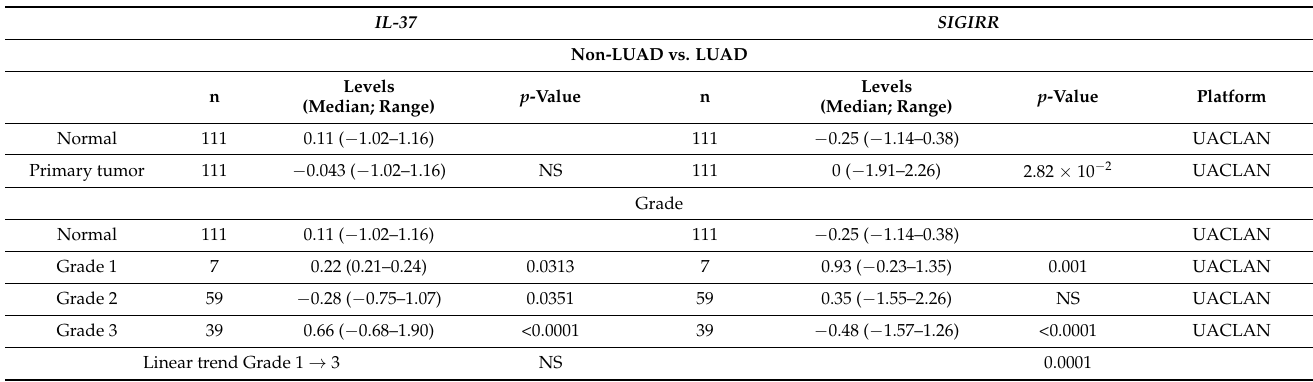
Figure 3. ( A ) Heatmap depicting the relative expression levels (log 2 TPM + 1) of IL-37 and twenty IL- 37-correlated genes in normal and LUAD biopsies as analyzed by RNAseq. ( B ) Dot plot diagrams showing the correlation between IL-37 and each of the twenty significantly positively correlated genes. No negative associations were detected. Pearson’s r values are reported in each case. All p -values were <0.0001. Figures were exported from http://ualcan.path.uab.edu/ [33] (accessed on 10 September 2022). ( C ) Heatmap depicting the grade of association between the expression levels of each of the twenty IL-37 -positively correlated genes and the levels of IL-37 . Pearson’s r values are reported. Table 3. Differential distribution of IL-37 and SIGIRR protein levels in LUAD vs. normal tissues or among LUAD tumors of different grades. Number of patients in each group, the median levels of expression, and their range as obtained from UALCAN portal [33], as well as p -values of statistical differences are